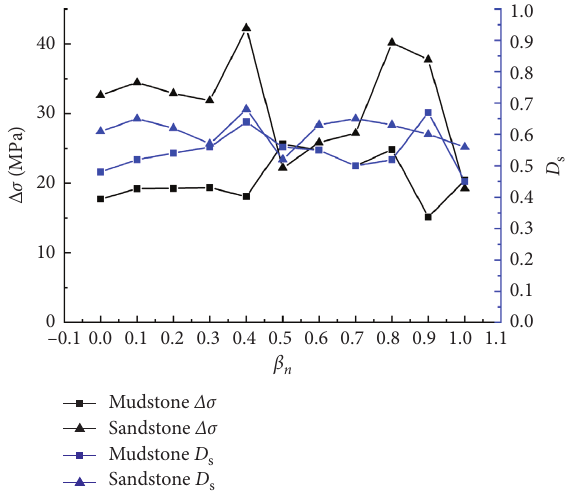
Figure 11: Intensity attenuation Δ σ and intensity attenuation coefficient D s of the two rocks under different β n